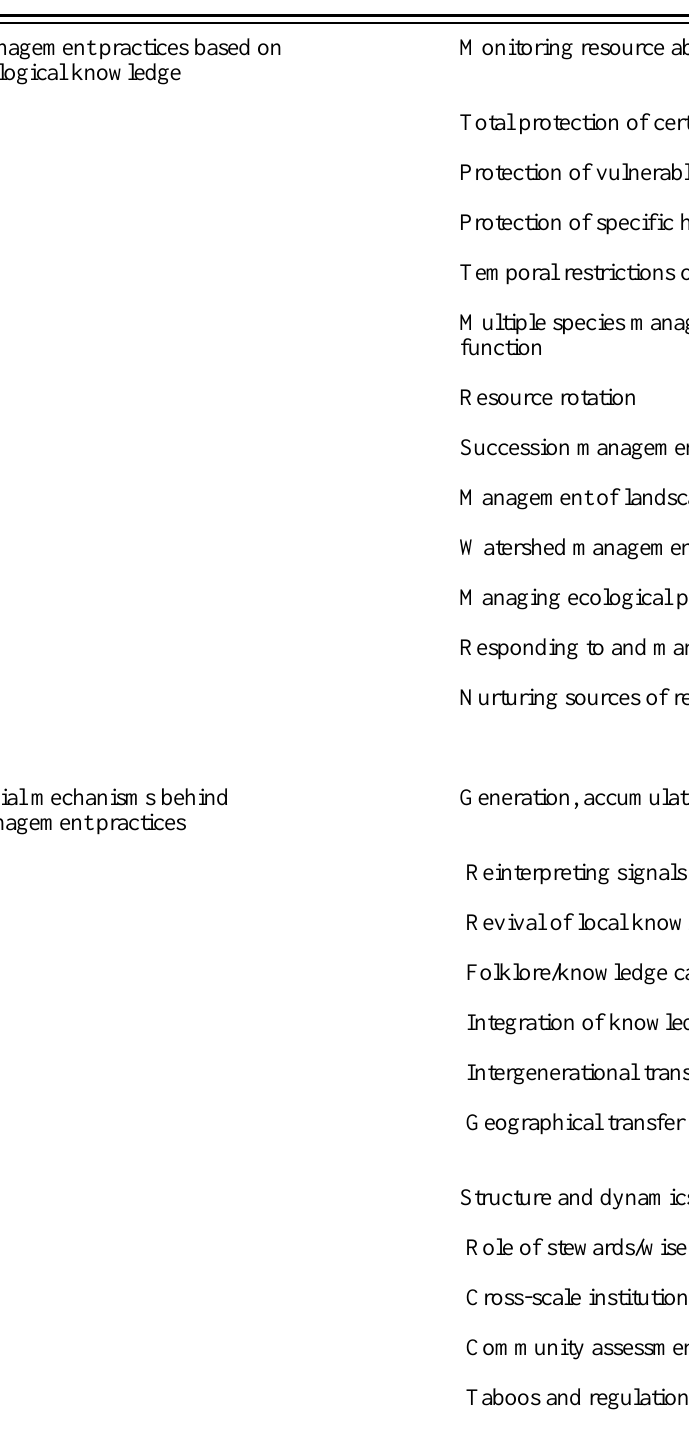
Table 2 . Ecologically adapted management practices and social mechanisms for resilience and sustainability (adopted from Folke et al. 1998 a